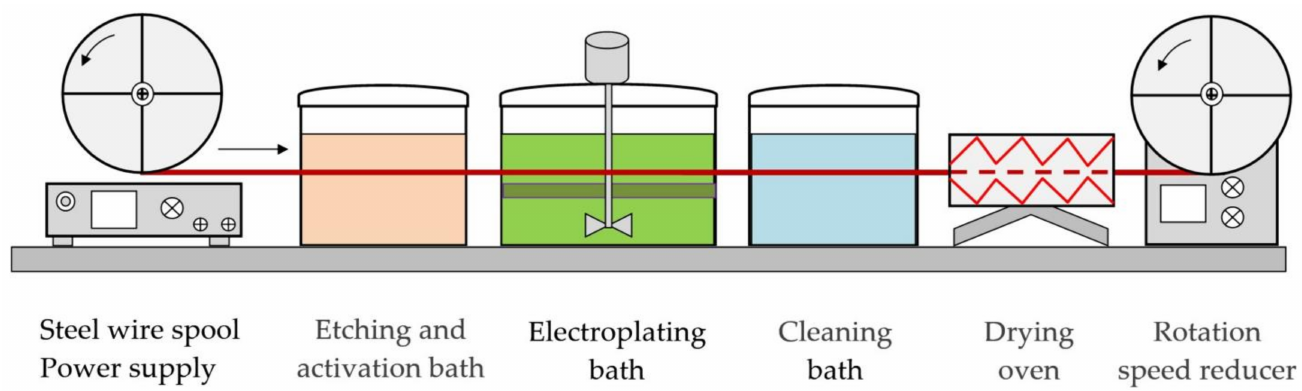
Figure 1. Schematic of the set-up used for treating welding wire and forming composite coatings. In the technology that is used to form composite coatings, the welding wire goes in the continuous process into the etching and surface activation bath from 10% aqueous solution of H 2 SO 4 at a feed rate of 0.5–2.5 m/min. The treatment at a temperature of 25 ◦ C removes impurities, organic contaminants, and oxide films from the wire surface. Then the wire goes into the main electroplating bath containing colloidal electrolyte with nano-dispersed wire in each bath is 7–36 s. After the composite coating is formed, the wire goes into